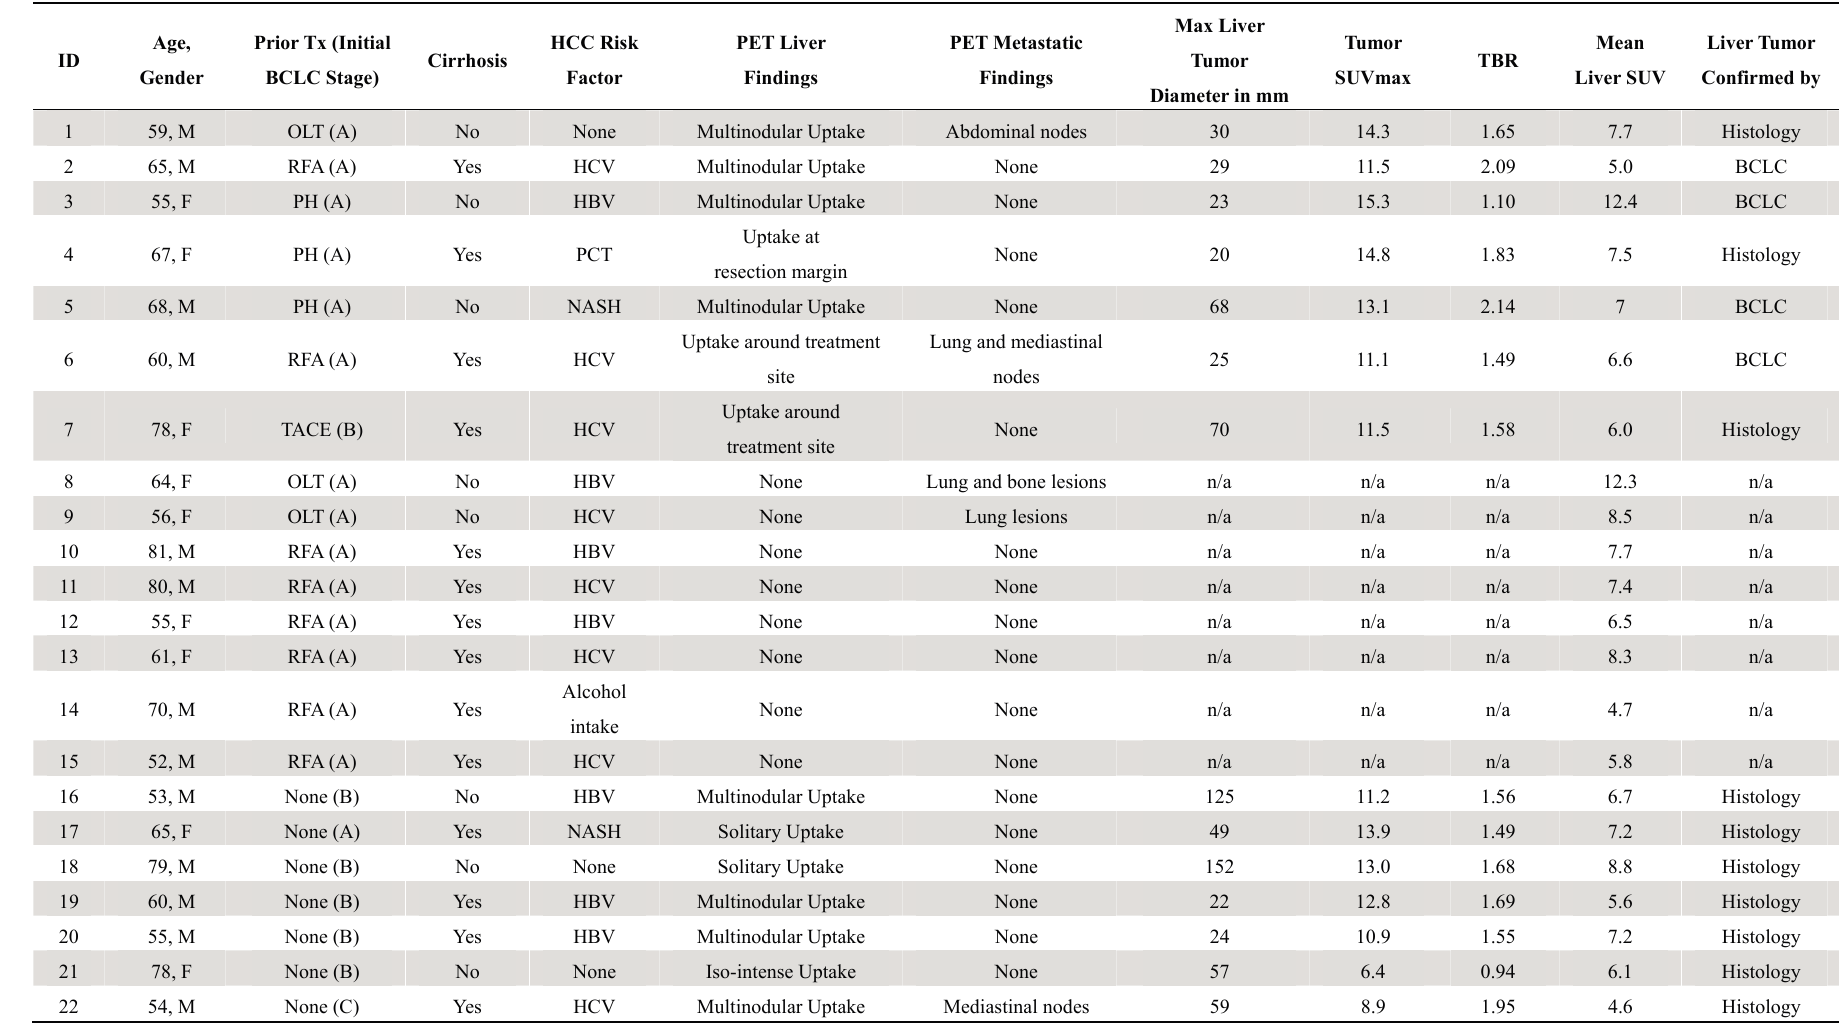
Table 1. Patient Characteristics and PET